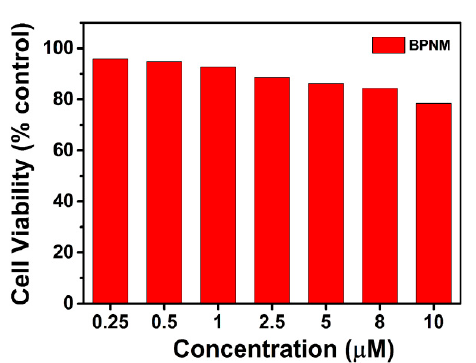
Figure 4. BPNM cytotoxicity analyzed by MTT assays at various concentrations (0.25, 0.5, 1, 2.5, 5.0, 8.0, and 10.0 μ M) in living MCF-7 cells for 12 h.